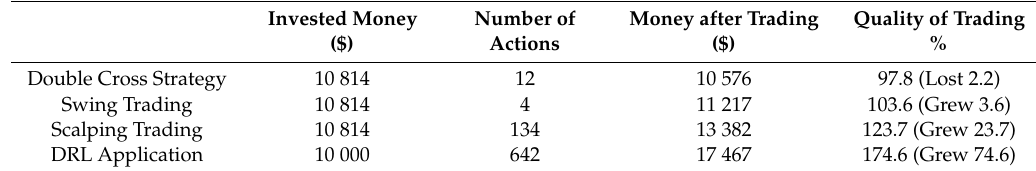
Table 5. Experiment results on Litecoin’s data.